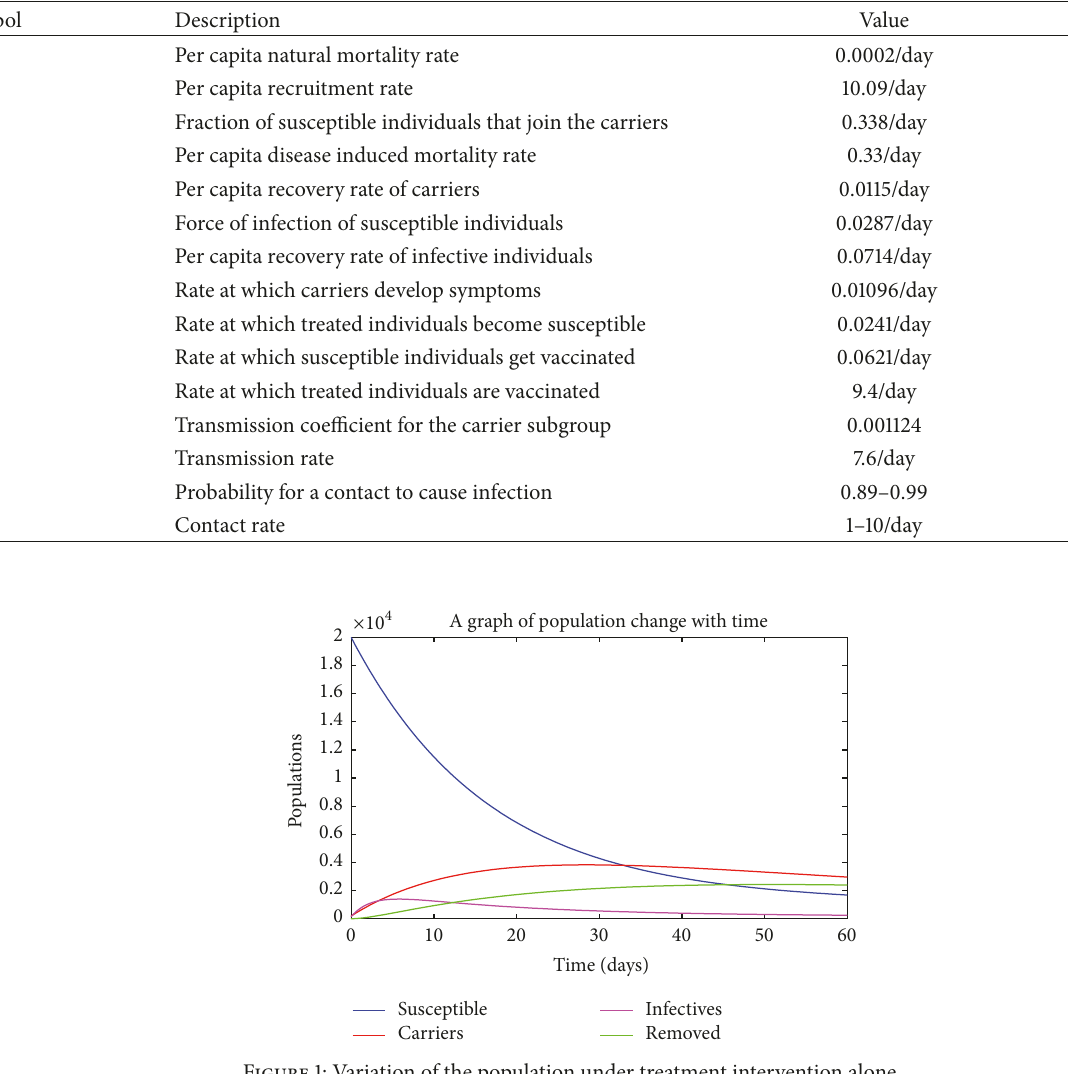
Figure 1: Variation of the population under treatment intervention